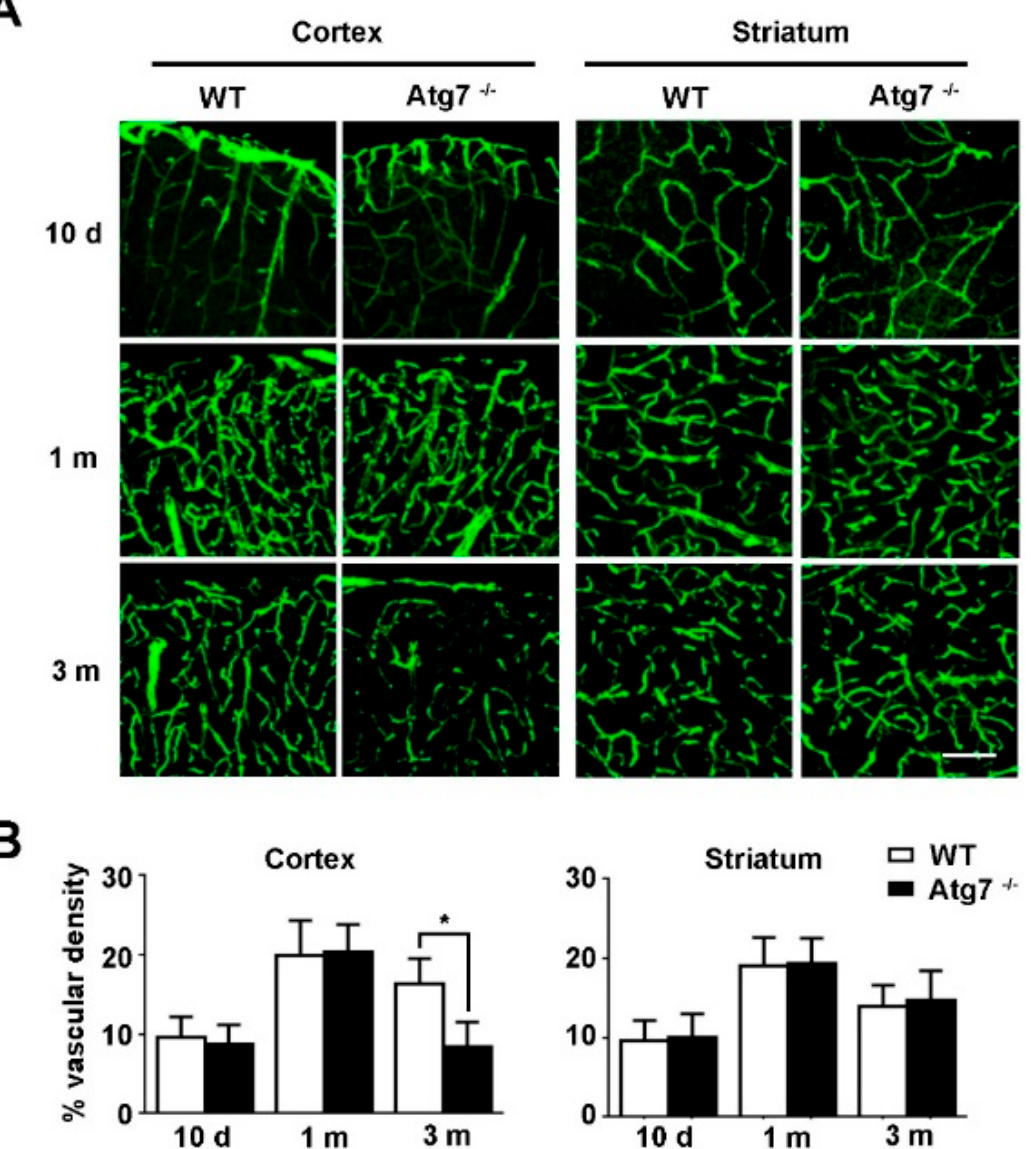
Figure 1. Brain microvessel changes in mice with endothelial-specific knockout of Atg7. ( A ) The tissue samples from brain cortex and striatum were obtained from transgenic mice with endothelial-specific knockout of Atg7 (Atg7 − / − ), with littermate wild-type mice as a control. Mice with different ages (10 days, 1 month, and 3 months) were analyzed, respectively. The brain slices were prepared using an oscillating microtome and immunofluorescence was performed with first antibody against platelet and endothelial cell adhesion molecule 1 (CD31, green). The stained slices were examined under confocal microscope ( n = 10 brain slices from 3 different mice).The representative images from three independent experiments were presented. Scale, 100 µ m; ( B ) The percentage of vascular density in ( A ) were calculated as follows: the vessel area is divided by the total image area and multiplied by 100. Images were analyzed by ImageJ software. * p < 0.05.